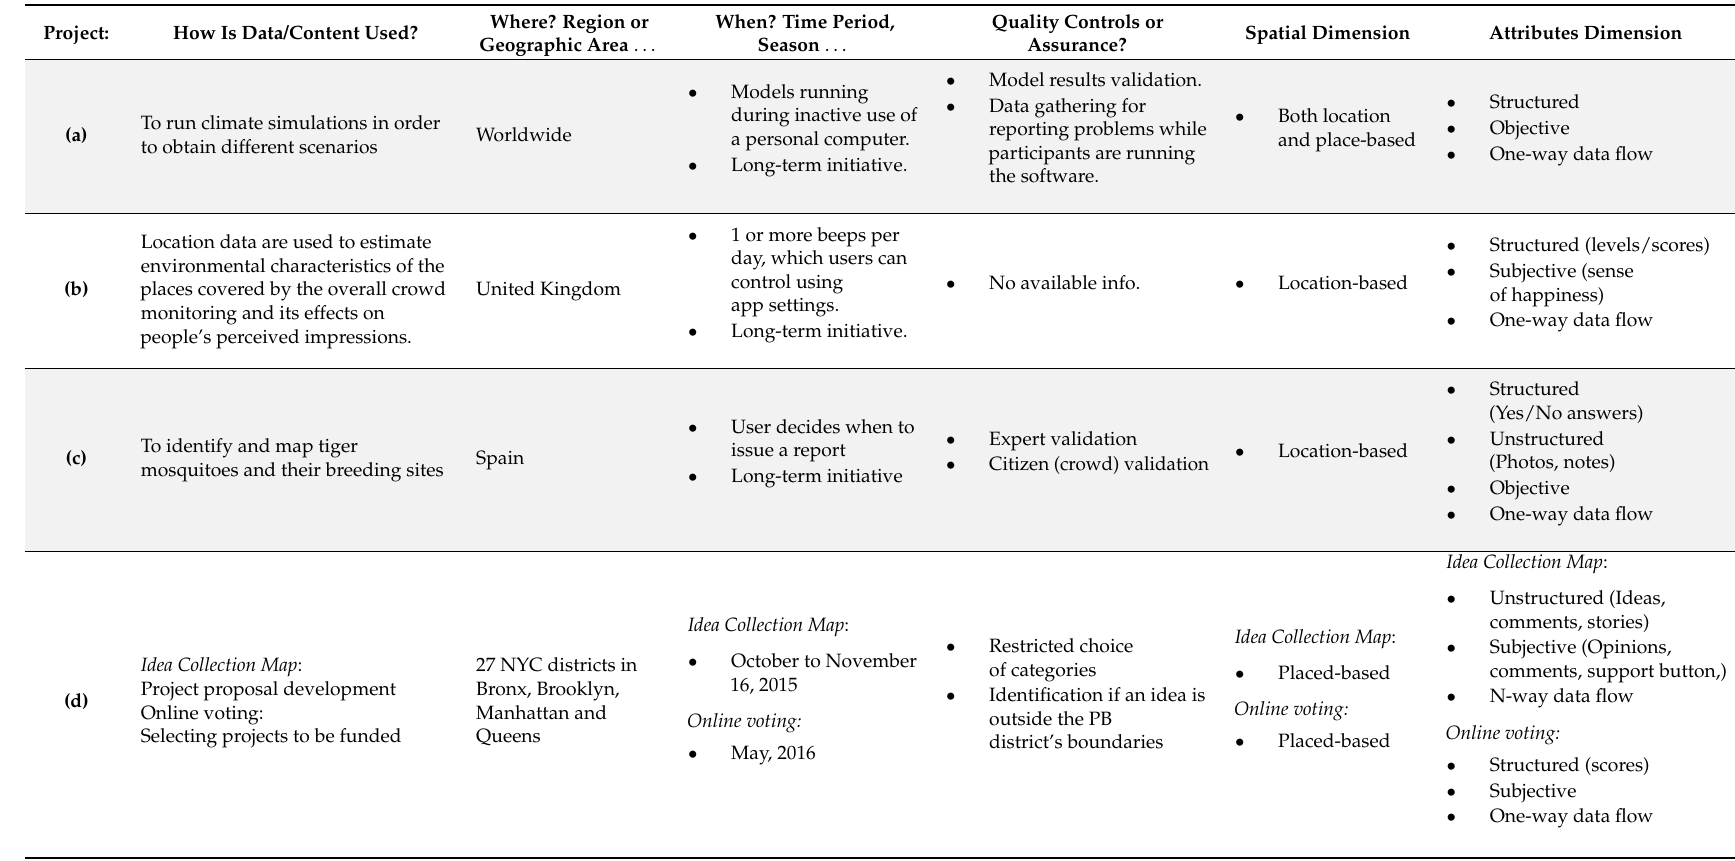
Table 7. VGI Project Design—Crowdsourced